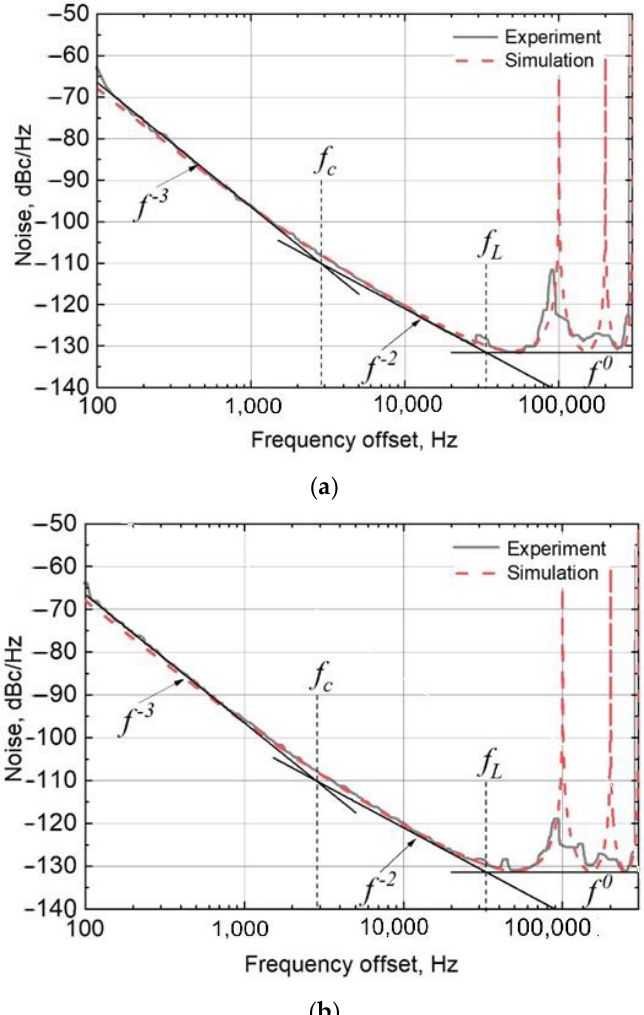
Figure 10. Phase noise of the OEO with narrowband demodulation as a function of the frequency offset for a generation frequency of 10 ( a ) and 12 GHz ( b ).